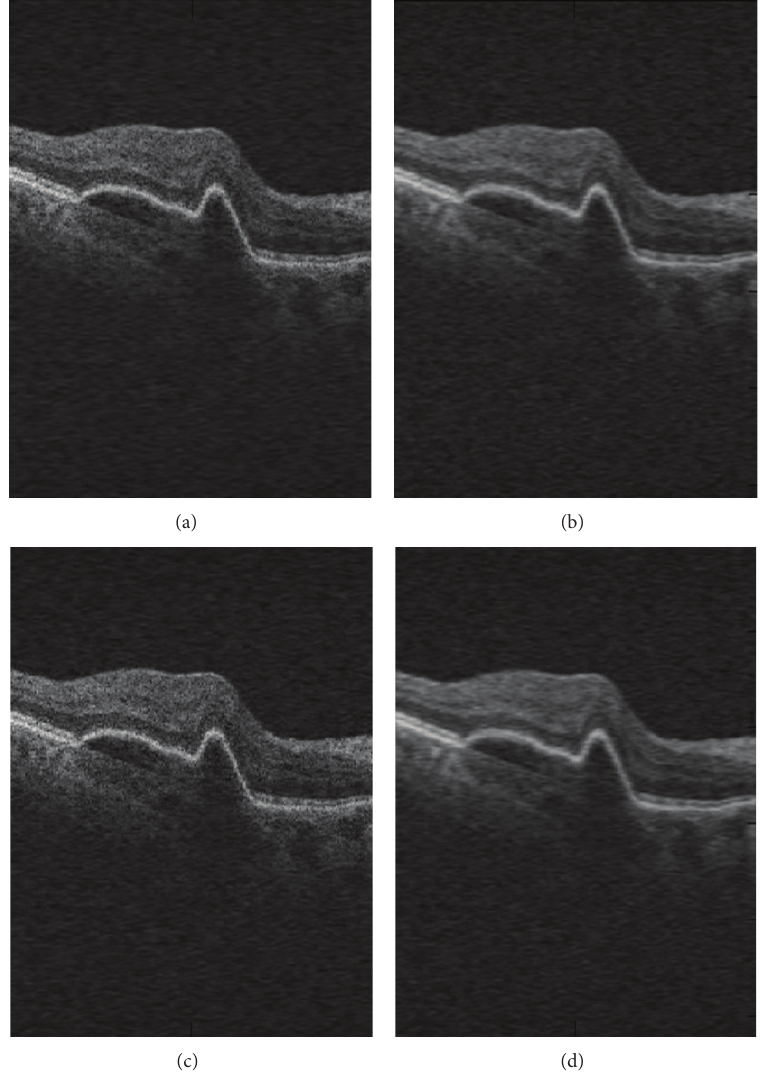
Figure 11: The results of applying homomorphic methods on proposed image in Figure 10. From top-left clockwise: despeckled data using BiGaussMixShrinkL, nonlocal BiGaussMixShrinkL, nonlocal BiGaussRayMixShrinkL, and